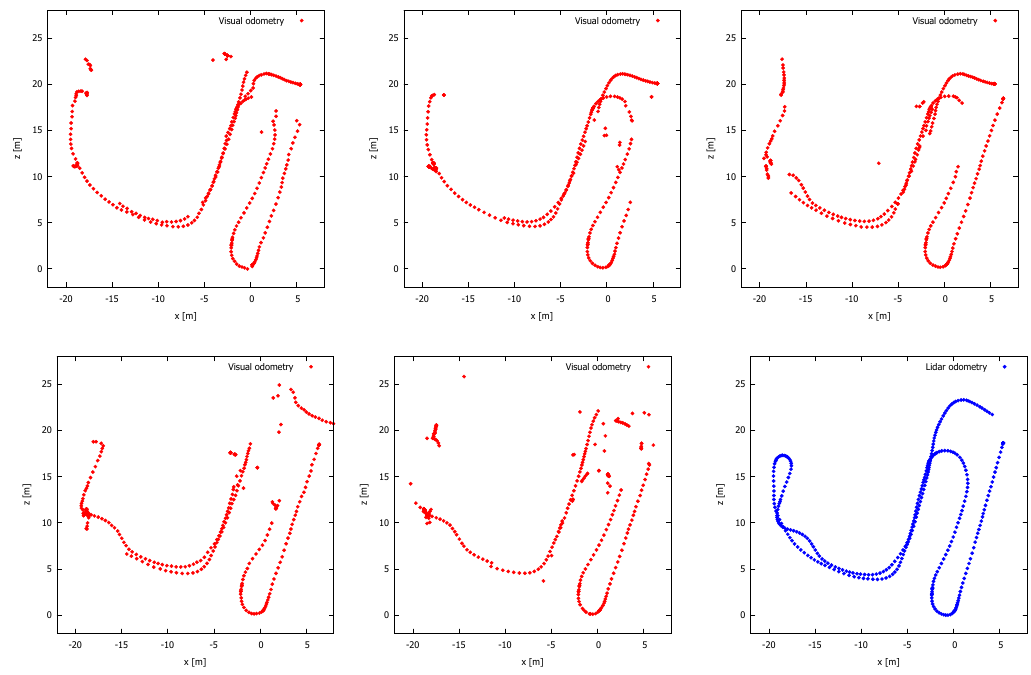
Figure 15. Five plots of the trajectories estimated by the visual structure from motion (SfM) framework presented in [28] using the images of each Ladybug camera separately (red color). The result of the camera pointing upwards is omitted. The blue plot represents the trajectory estimated using our method. For the visual SfM approach, many poses are missing due to the lack of good feature matches. Moreover, many outlier poses are present.